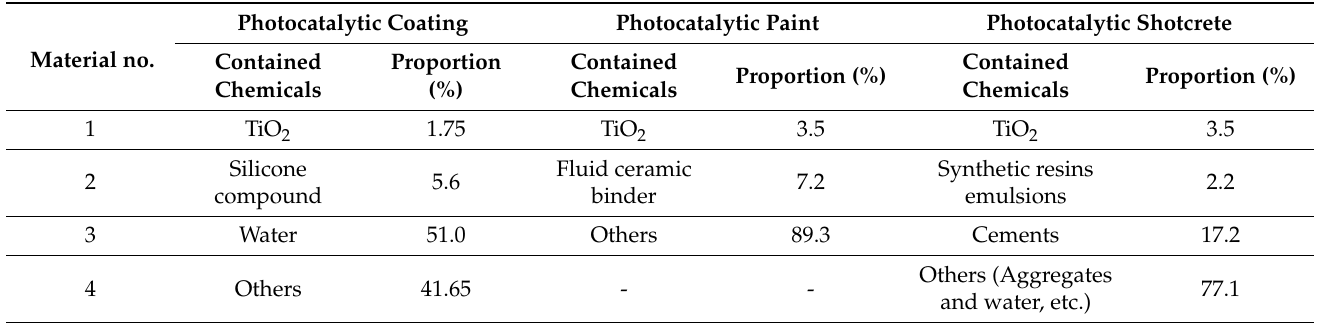
Table 2. Composition of photocatalytic